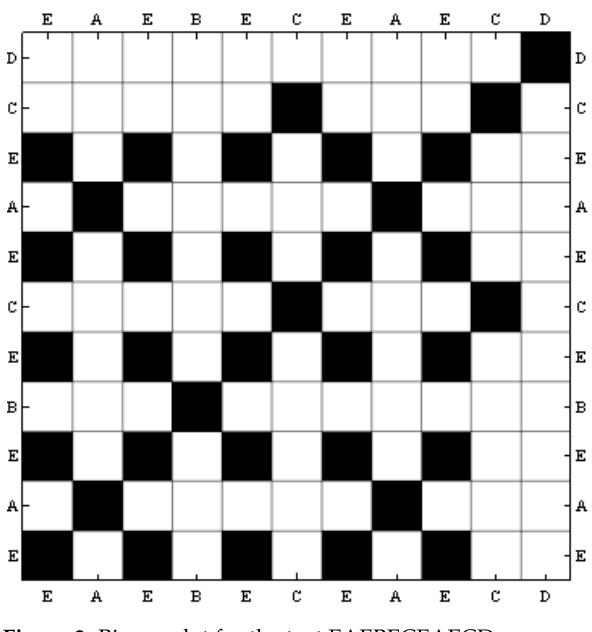
Figure 3. Binary plot for the text EAEBECEAECD. From where it can be easily seen that there is the recurrent patch of Figure 4.